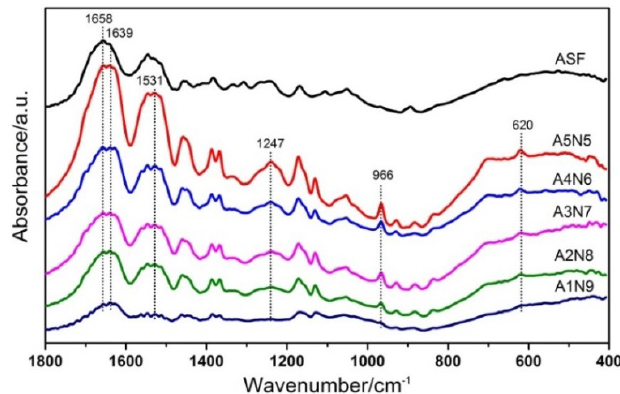
Figure 5. FTIR absorbance spectra of different composite hydrogels.